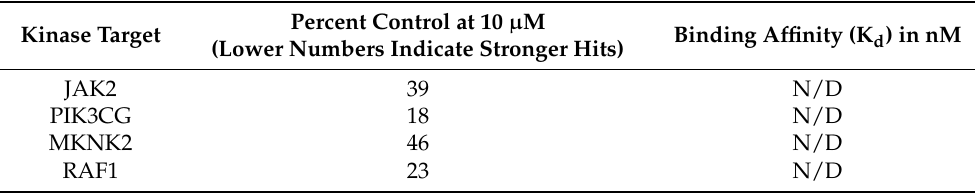
Table 1. Kinase binding assay of MBZ for predicted kinase